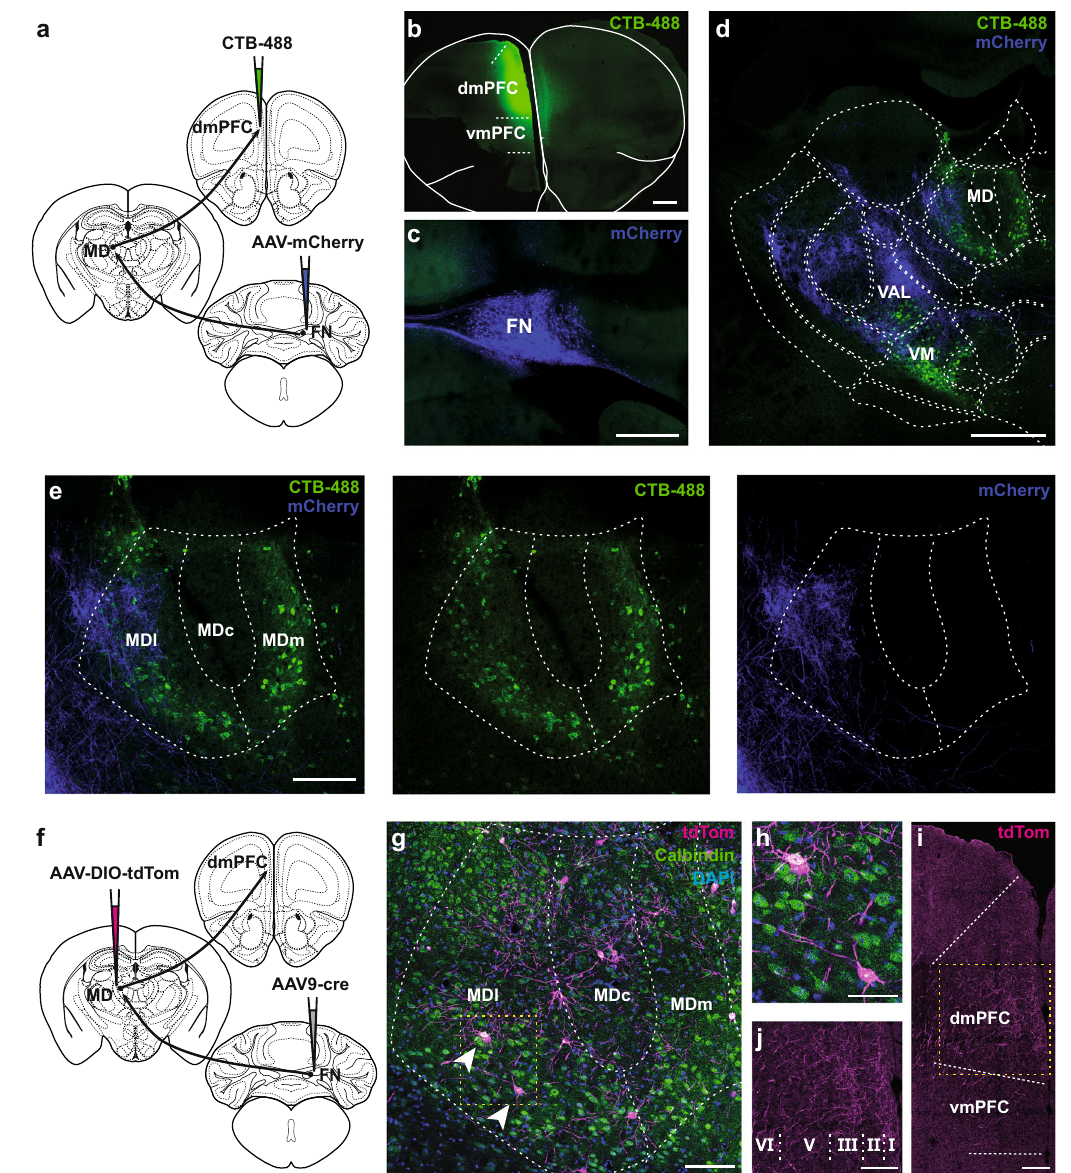
Fig. 2 | MD as a high-order thalamic relay between the FN and the dmPFC. a Strategy for neuroanatomical tracing by injections of anterograde AAV-mCherry in the FN and retrograde CTB-488 in the dmPFC ( n =3 replicates). b Example of CTB-488injectionsiteinthedmPFC(scalebar,500 µ m). c AAV-mCherryexpression inthecerebellarFN(scalebar,500 µ m). d Thalamicsectionexhibitingcontralateral FNprojections(mCherry,blue)andthalamicdmPFC-projectingneurons(CTB-488, green)(scalebar,500 µ m). e Zoom-infromthalamussectionin d (dottedlinearea), showingtheFNprojectionstoMD,preferentiallyintothelateralsegmentoftheMD (MDl). MDc: central segment of MD, MDm: medial segment of MD. (scale bar, 100 µ m). f Schematic representation of viral strategy to localize FN-post-synaptic neurons in MD. Anterograde trans-synaptic expression of cre by AAV9 and cre- dependent expression of td-Tomato in MD. ( n =3 replicates) g MD exhibiting FN-